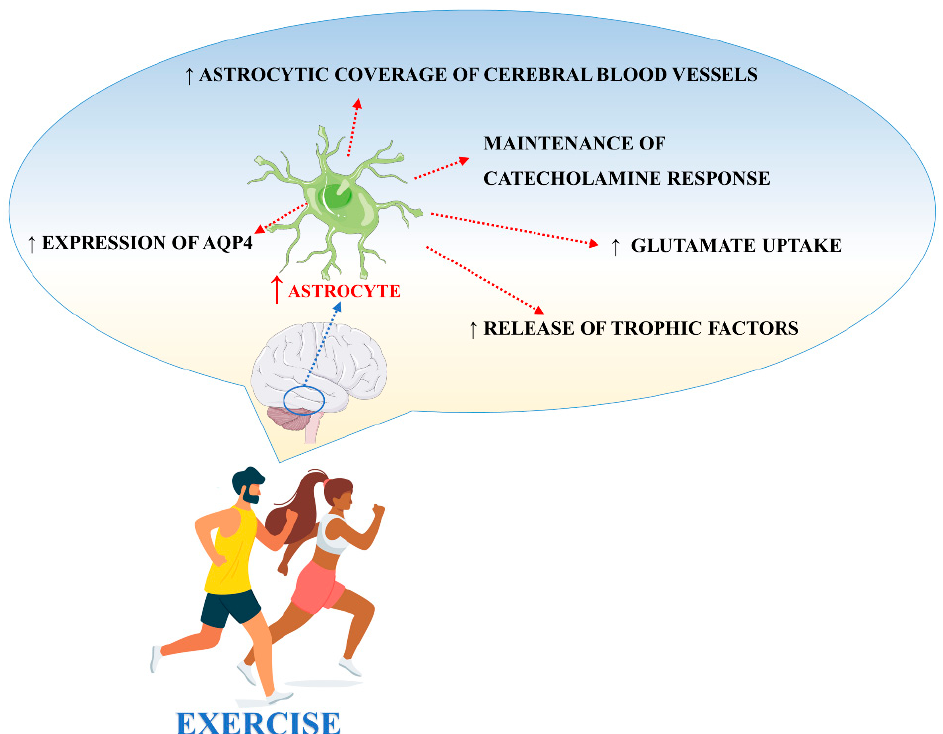
Figure 3. Main processes involved in exercise-induced modulation of astrocyte activities. It is well known that oxidative stress is a common feature of different neurodegenera- tive diseases, including AD, and astrocytes represent the main actors of the antioxidant response in the brain [85]. It has been shown that a five-week treadmill training of rats subjected to intracerebroventricular administration of streptozotocin (to model sporadic AD) increased the hippocampal content of astrocytic glutathione in CA1 region [86]. Fur- thermore, rats subjected to combined caloric restriction and moderate treadmill exercise consisting of 20 min, three times a week for twelve weeks, showed an increase in gluta- mate uptake from the extracellular space, suggesting a key role for astrocytes in avoiding excitotoxicity damage and eventually, neuronal death [87]. Belaya et al., investigated the positive role of exercise in 5xFAD mice, a well-known AD model featured by rapid and early onset A β plaque deposition (i.e., starting from 2 months of age). The results showed that voluntary physical exercise increased GFAP-positive astrocytes in the hippocampi compared with wild-type (WT) mice. In addition, astrocytes showed an enlarged soma area, solid shape, and presented with atrophic branches, and most of these cells were plaque-associated [88]. In contrast, long-term treadmill exercise reduced the number